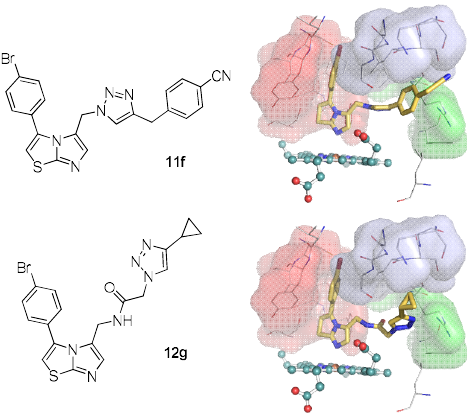
Figure 3. Structure and docking pose of the most potent imidazothiazoles 11f and 12g . Structures of docking poses are depicted as gold sticks, while heme is depicted as cyan sticks. Amino acids of pocket A, B and C are depicted as red, green and blue lines shape, respectively.